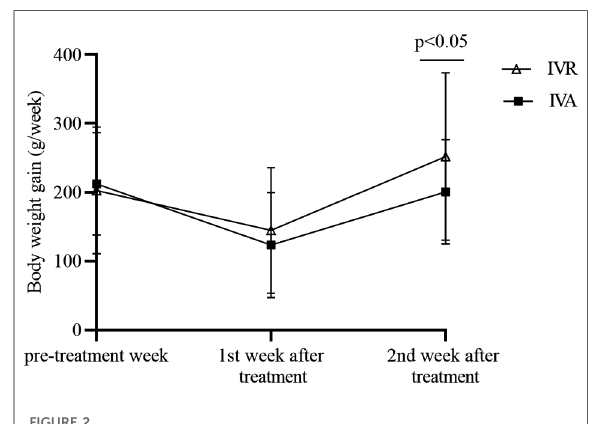
FIGURE 3 Comparison of the weekly BW gains for the fi rst post-treatment week based on the BW at